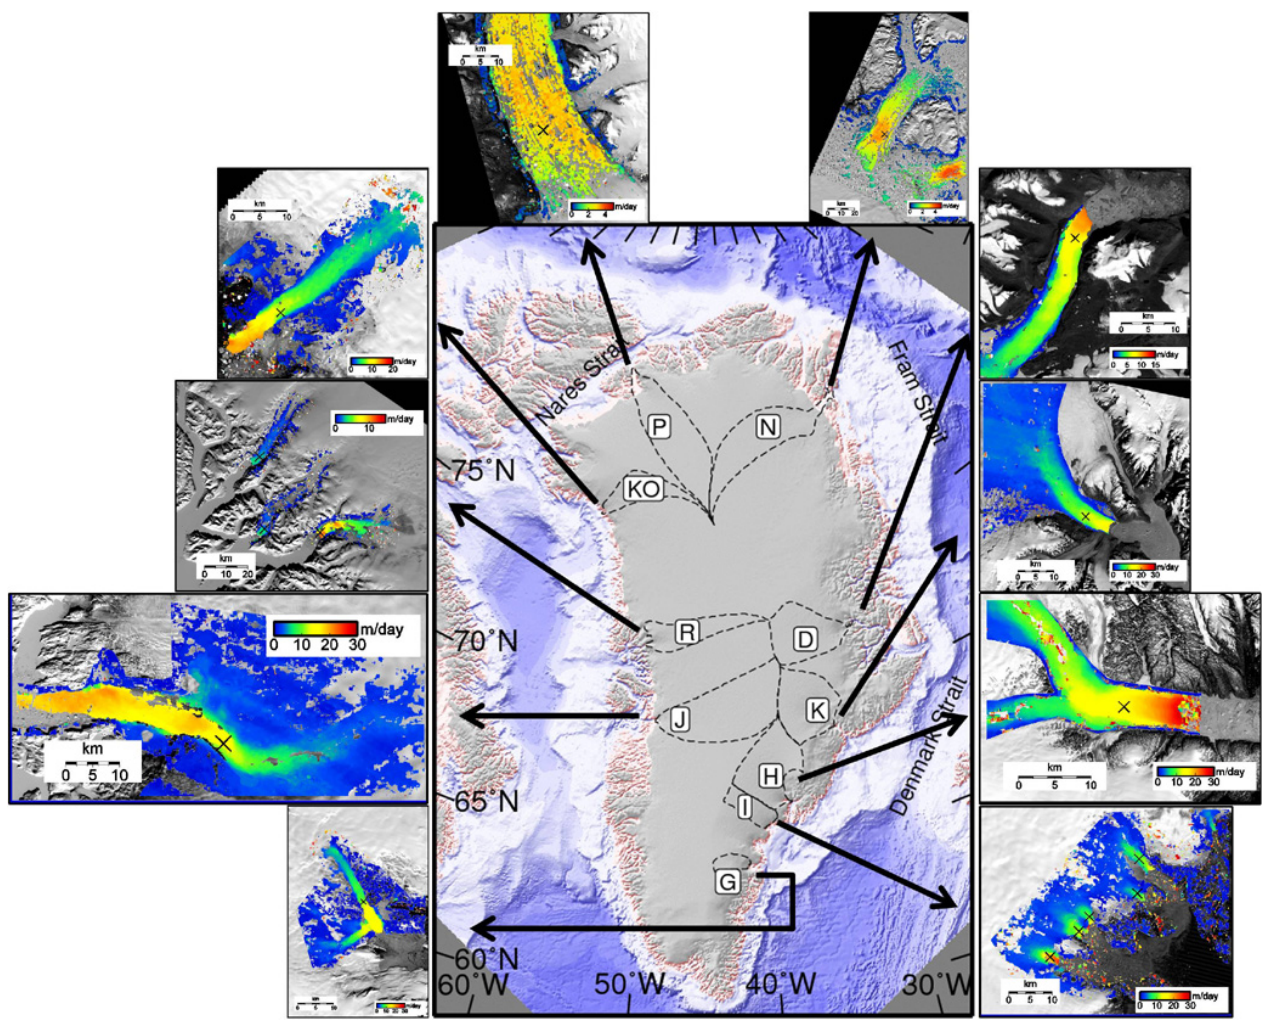
Fig. 1. Outlet glacier catchments. D = Daugaard-Jensen, K = Kangerdlugssuaq, H = Helheim, I = Ikertivaq, G = Gyldenlove, J = Jakobshavn Isbræ, R = Rink Isbræ (including Umiamako and Ingia Isbræ), KO = Kong Oscar, P = Petermann, N = Nioghalvfjerdsbrae. Dates for the sample speed map images are listed in Table 1, and the velocity data extraction points are marked with Xs. Shaded relief and bathymetry based on the International Bathymetric Chart of the Arctic Ocean (Jakobsson et al.,